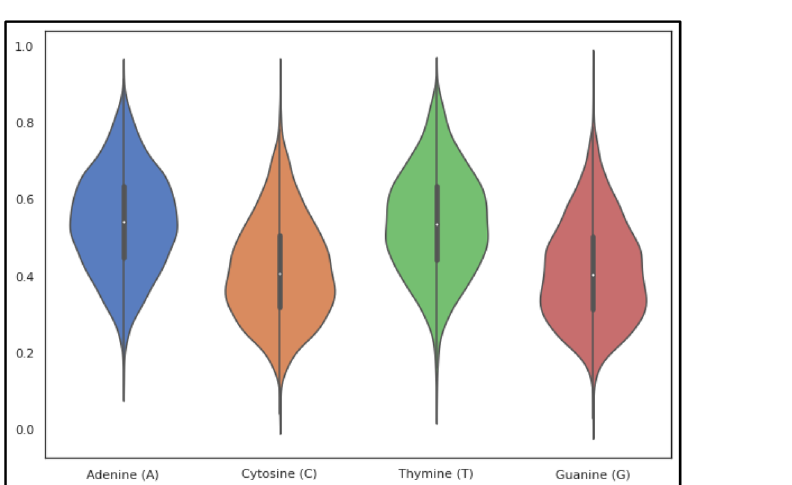
Figure 4. ( a ) The violin plot of nucleotide adenine (A) composition. ( b ) The violin plot of nucleotide cytosine (C) composition. ( c ) The violin plot of nucleotide thymine (T) composition. ( d ) The violin plot of nucleotide guanine (G) composition.